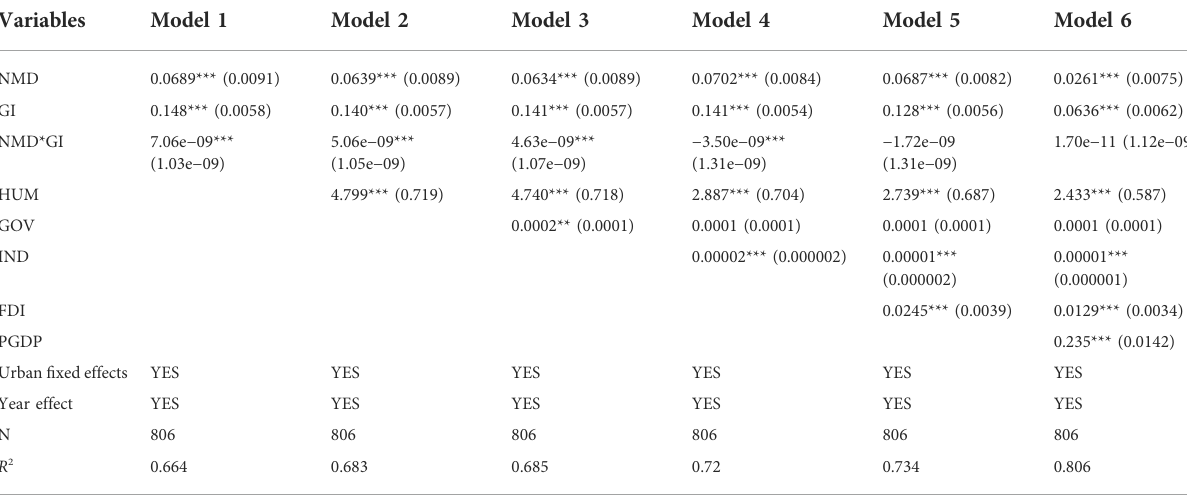
TABLE 3 Analysis of baseline regression results (with HQD as the dependent